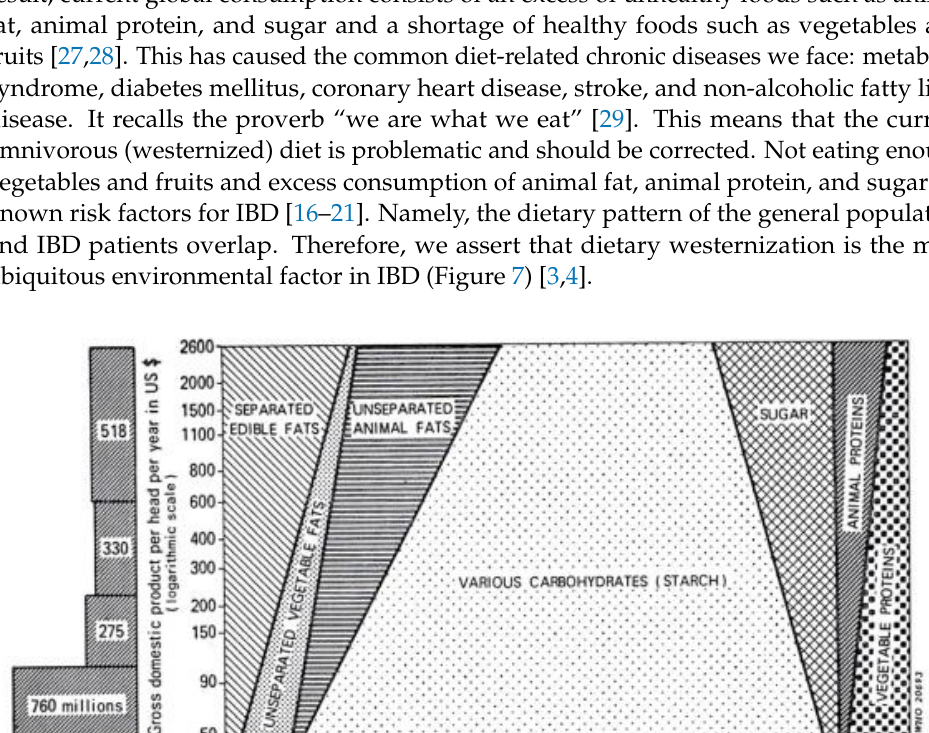
Figure 5. Correlation between Crohn’s disease and ulcerative colitis in the annual numbers of new cases in Japan. In Japan, the national registration of ulcerative colitis cases and Crohn’s disease cases started in 1975 and 1976, respectively. A scattergram was generated based on data for 24 years from 1977 to 2000. The linear regression formula and correlation coefficient are shown.